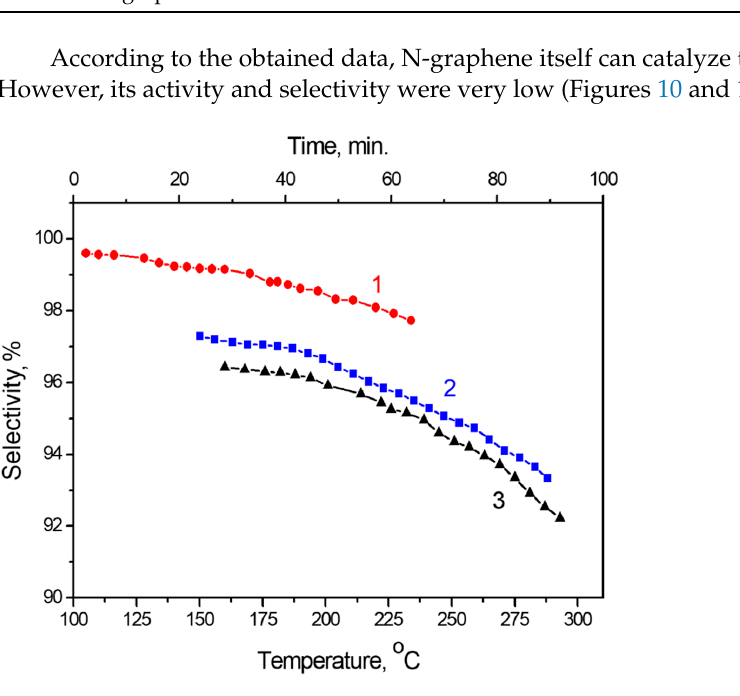
Figure 11. Dependence of the selectivity in the FA decomposition to hydrogen and CO 2 on